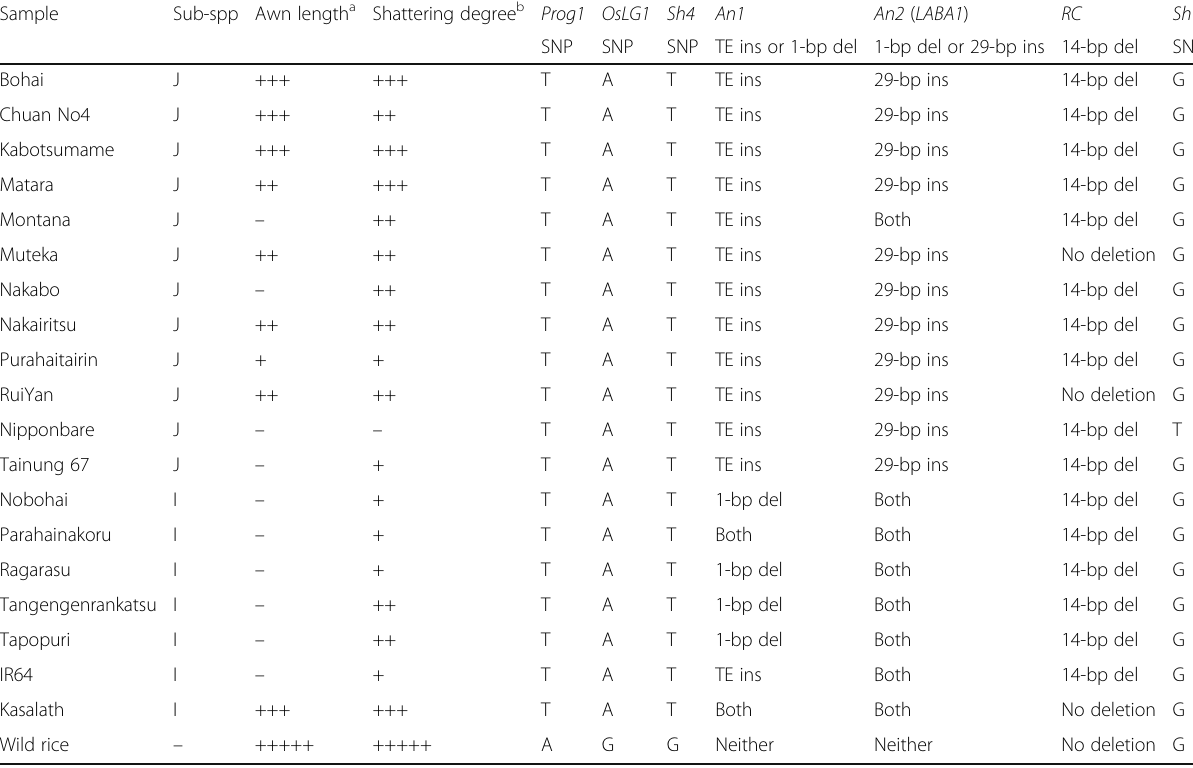
Table 3 Summary of sequence changes in early domestication-related genes